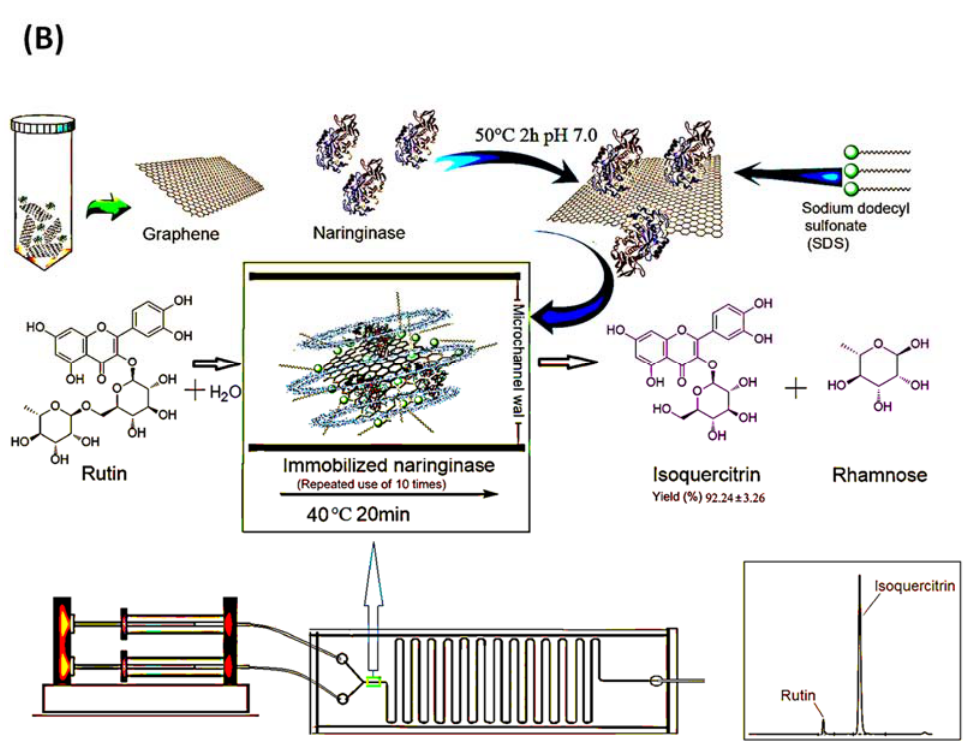
Figure 1. Schematic diagram of drug synthesis by Microchannel reactor: ( A ) Schematic diagram of the biosynthesis of ibuprofen in a microchannel reactor from [26], Copyright 2021, American Chemical Society. ( B ) Schematic diagram of the biosynthesis of isoquercitrin in a microchannel reactor from [35], Copyright 2017, Nature Publishing Group.